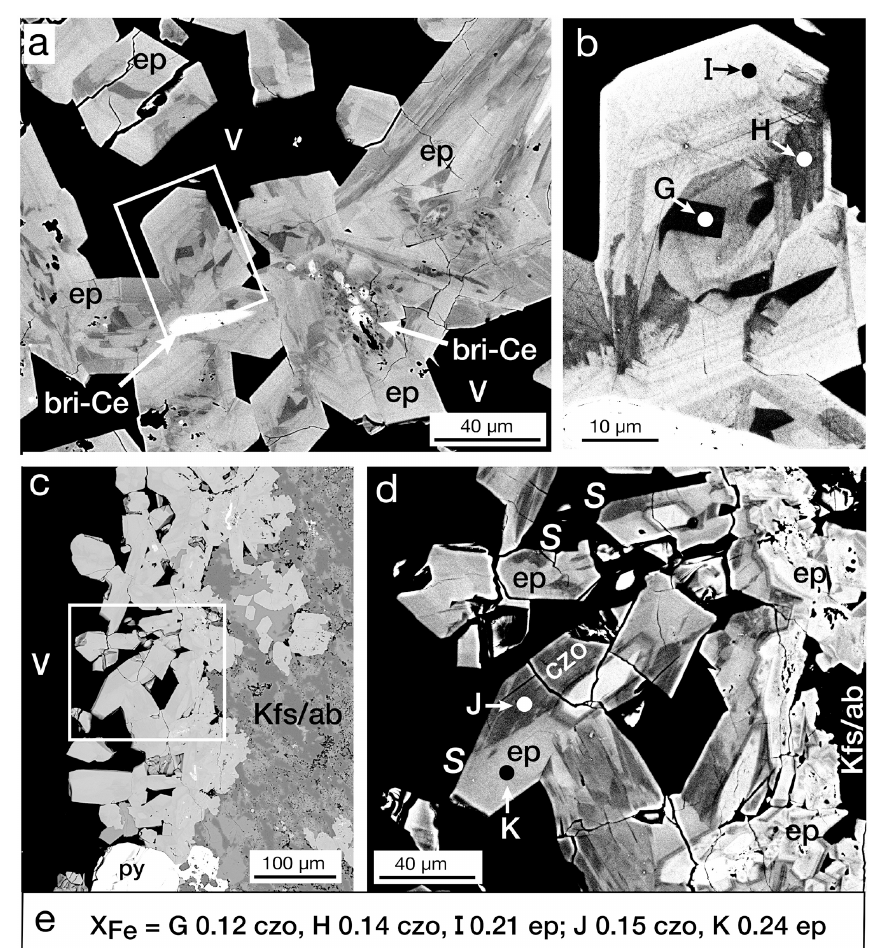
Figure 8. BSE images: (a) complexly zoned crystals of epidote (ep) in a vug (V) with cores of britholite-(Ce) (bri-Ce), sample MF2-1824. The rectangle is enlarged in (b) . (b) Crystal from thin section shown in (a) oriented vertically, illustrating complex zoning. Spots G and H are clinozoisite, and I is epidote. (c) Edge of a vug (V) in K-feldspar/albite (Kfs/ab) lined with complexly zoned epidote (ep) crystals, sample MF1-1597. Square enlarged in (d) . (d) Sector-zoned crystals ( S ) with relatively unzoned epidote cores. The sector compositions vary between epidote (ep: spot K) and clinozoisite (czo: spot J). (e) Values of X Fe [(Fe 3 + ) / (Fe 3 + + Al)apfu] for the EPMA analytical spots G–K for epidote (ep) and clinozoisite (czo) shown in Fig. 8b and d; analyses are given in Table